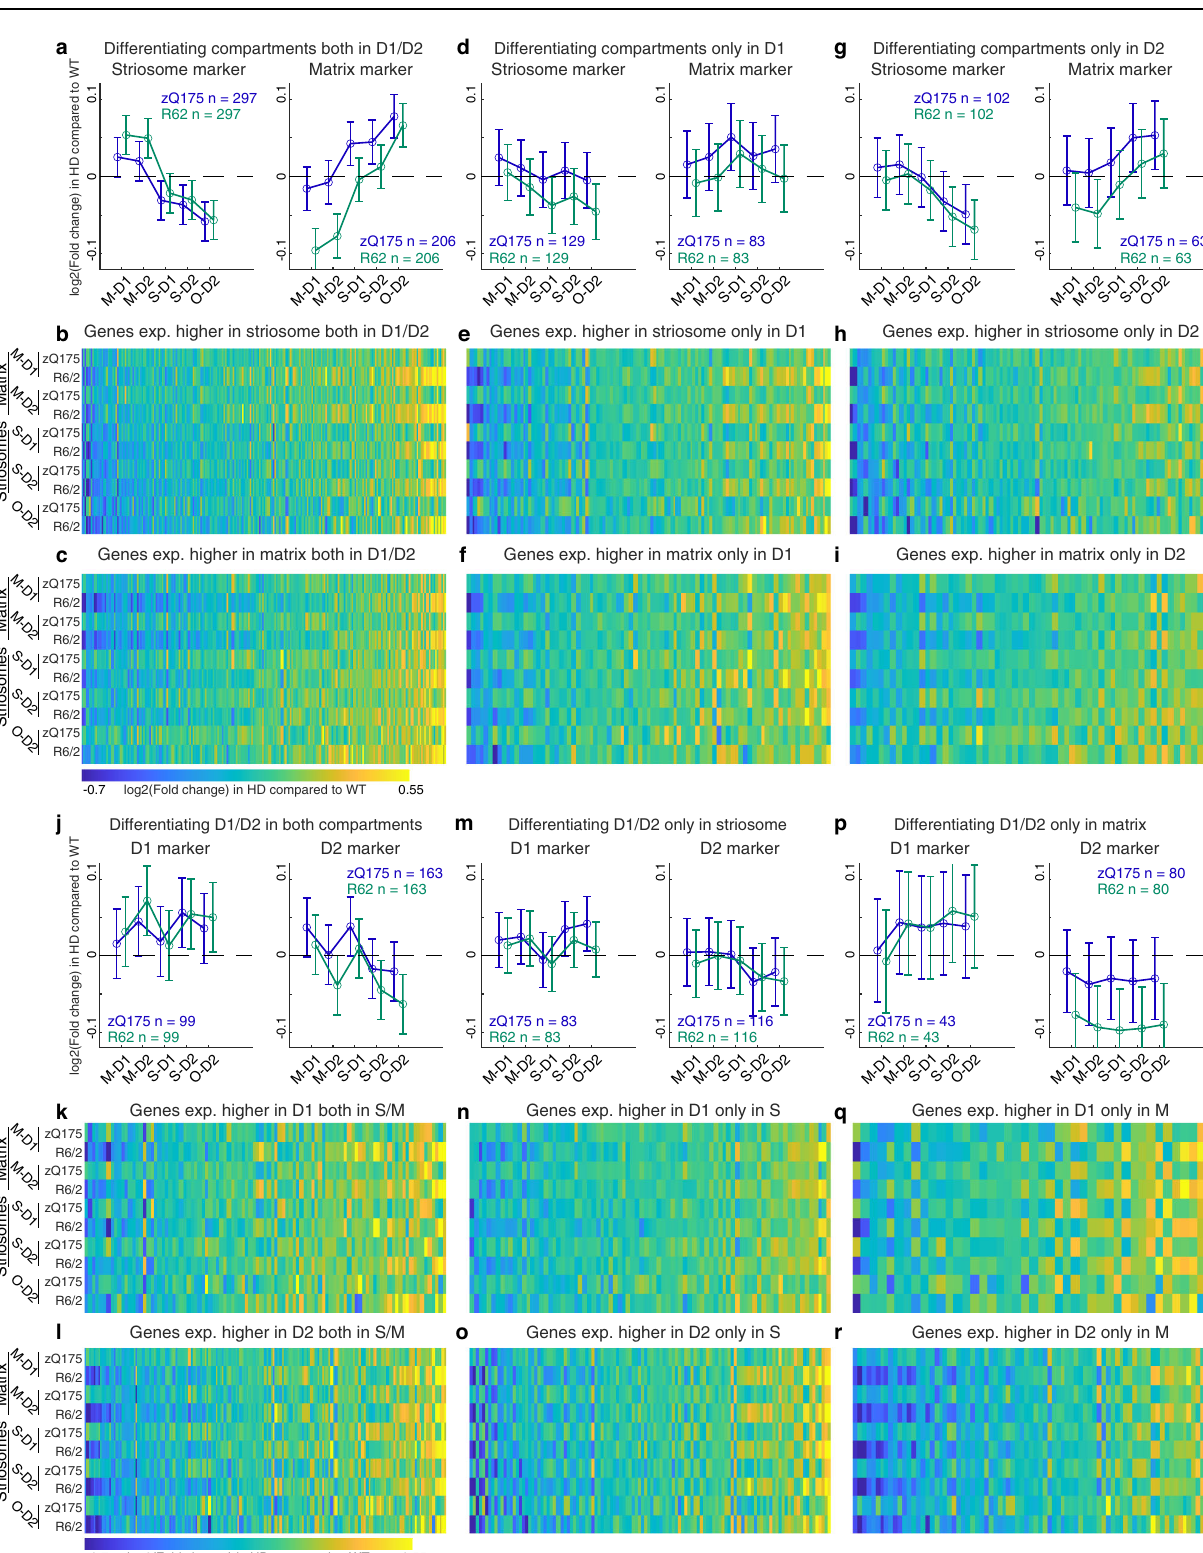
markers, was clear in those transcripts differentiating S-D2 and M-D2 (Fig. 3a, g) but was not uniformly detectable in those differentiating only S-D1 and M-D1, e.g., both striosome and matrix markers exhibited a tendency to be upregulated in M-D1 of zQ175 mice (Fig. 3d). The patterns held even after applying stricter criteriato de fi ne markers; we found similar, even clearer, patterns when we included S-M markers